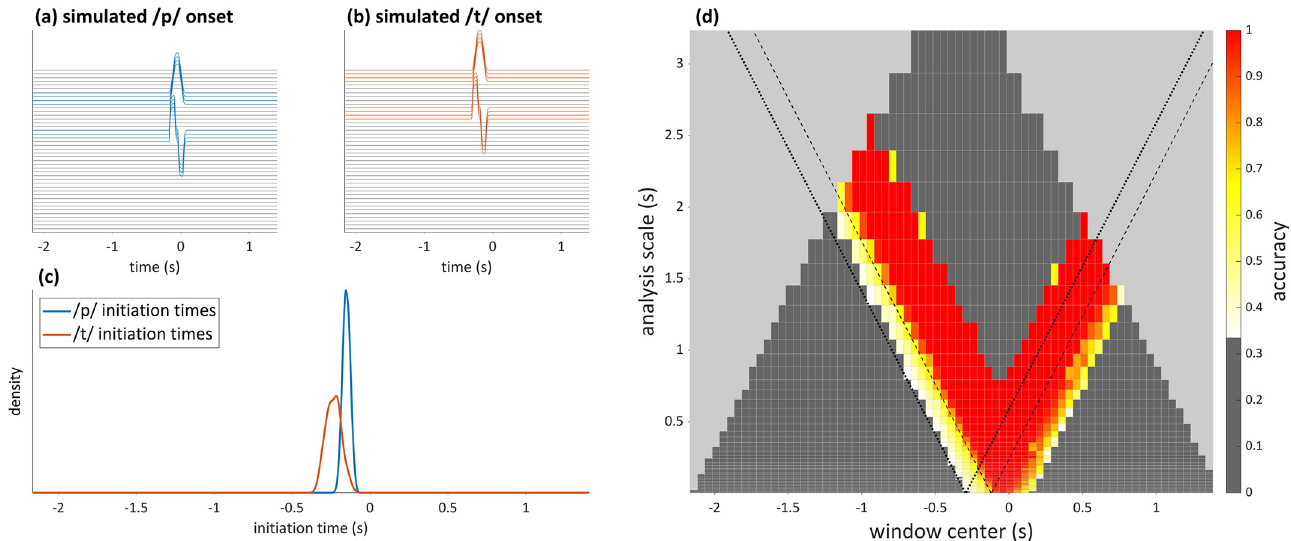
Fig 13. Illustration of decline in network accuracy associated with large window sizes, using simulated data. (a, b) Simulated articulatory signals associated with simulated /p/ and /t/ onsets. (c) Gaussian kernel smoothed density distributions of movement initiation times matching empirical distributions. (d) Scalogram showing accuracy decrease at large analysis